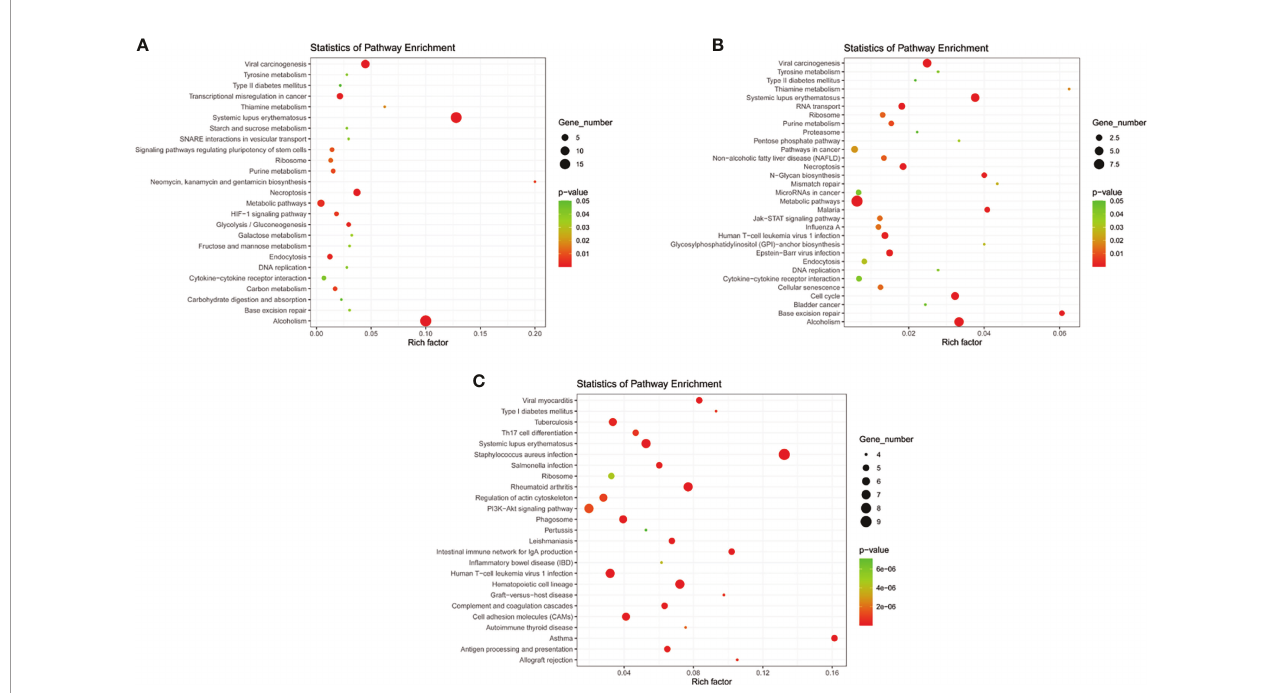
FIGURE 5 | KEGG pathway analyses of important lncRNAs (intersection of all genes in selected module and differentially expressed lncRNAs) in (A) T2DM versus normal controls, (B) T2DM versus prediabetes and (C) prediabetes versus normal controls.